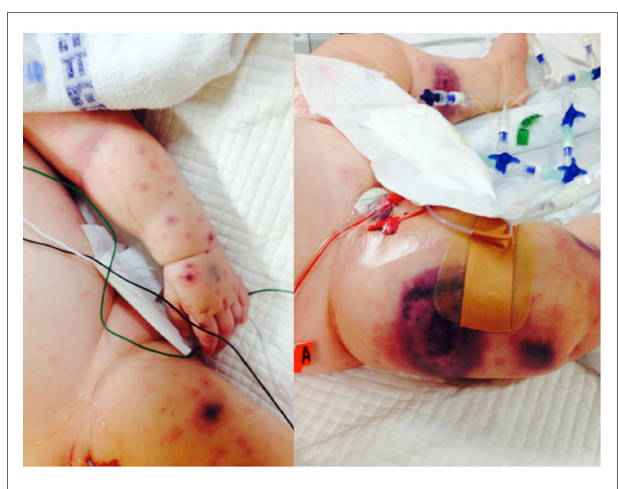
FigUre 1 | ecthyma gangrenosum, a highly suggestive rapidly progressive purpuric skin lesion seen in a minority of children with P. aeruginosa bacteremia, is shown in one of the study patients (with permission from parents)